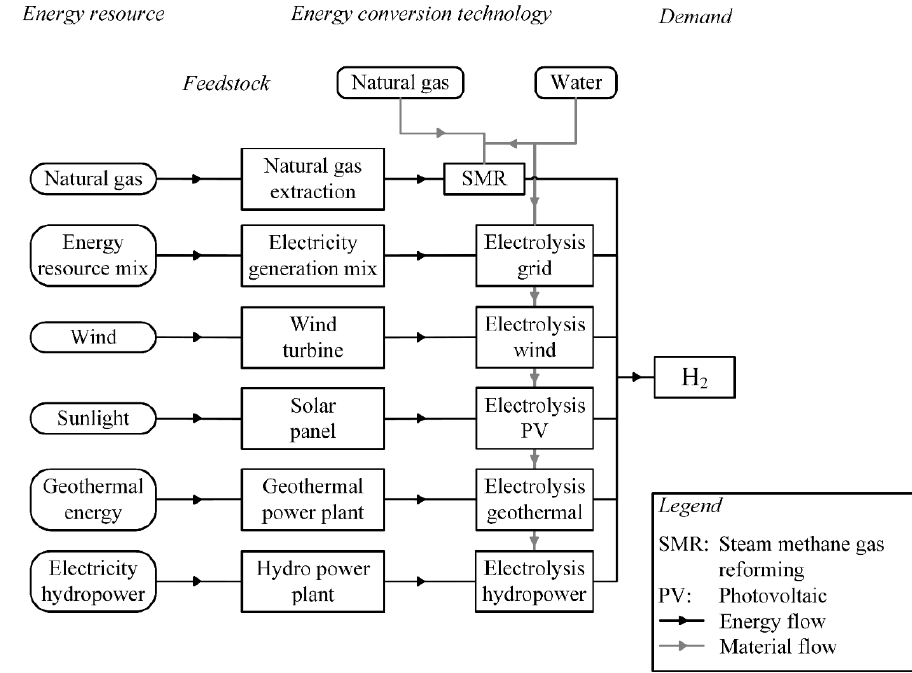
Figure 2. Energy and material flows associated with hydrogen production.